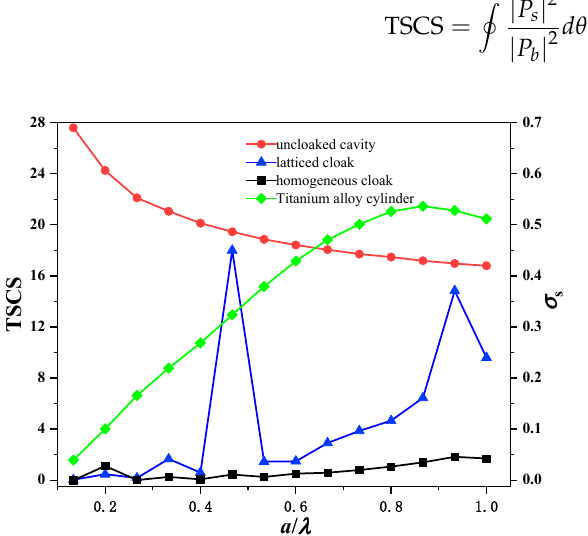
Figure 14. TSCS spectra of PM acoustic cloak.